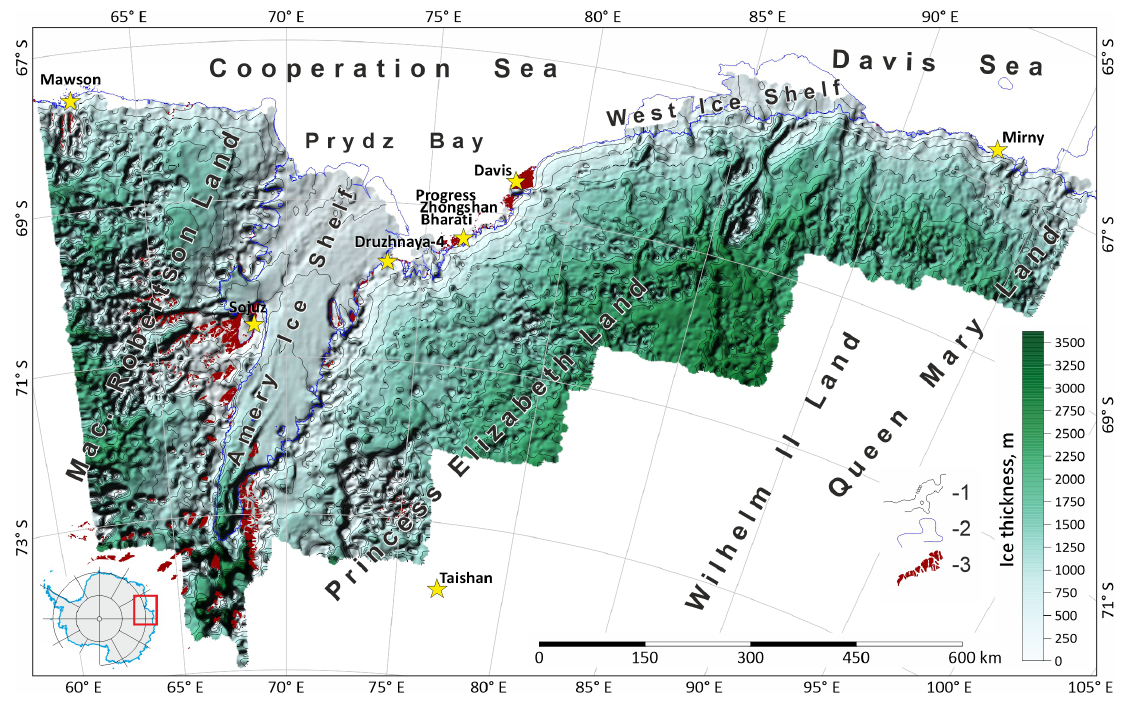
Figure 5. Ice thickness of the research area. 1—Ice thickness contours in meters; contour interval is 250 m; 2—ice front and grounding line from [20]; 3—outcrops from